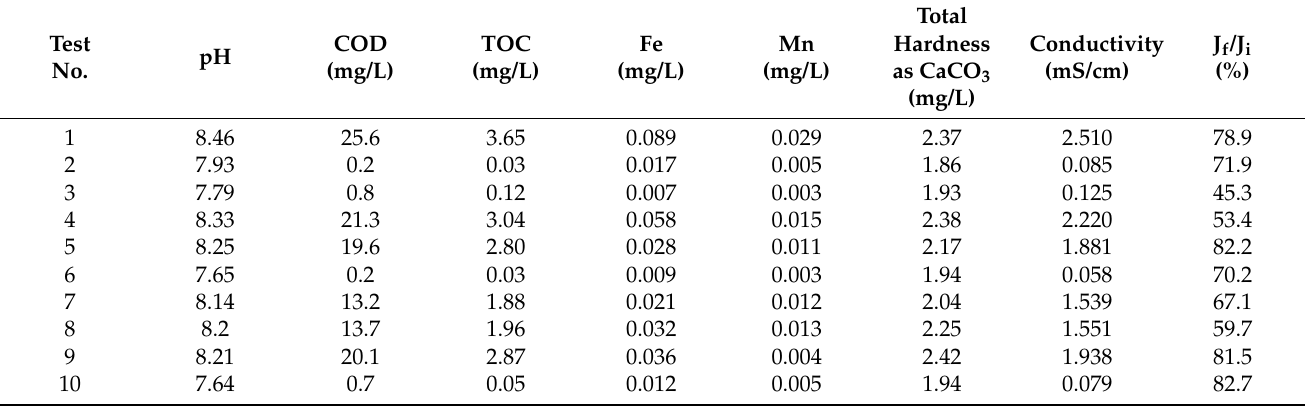
Table 8. Permeate quality and final flux of Vontron HOR RO membrane in the orthogonal (No. 1–9) and demonstration (No. 10) tests.